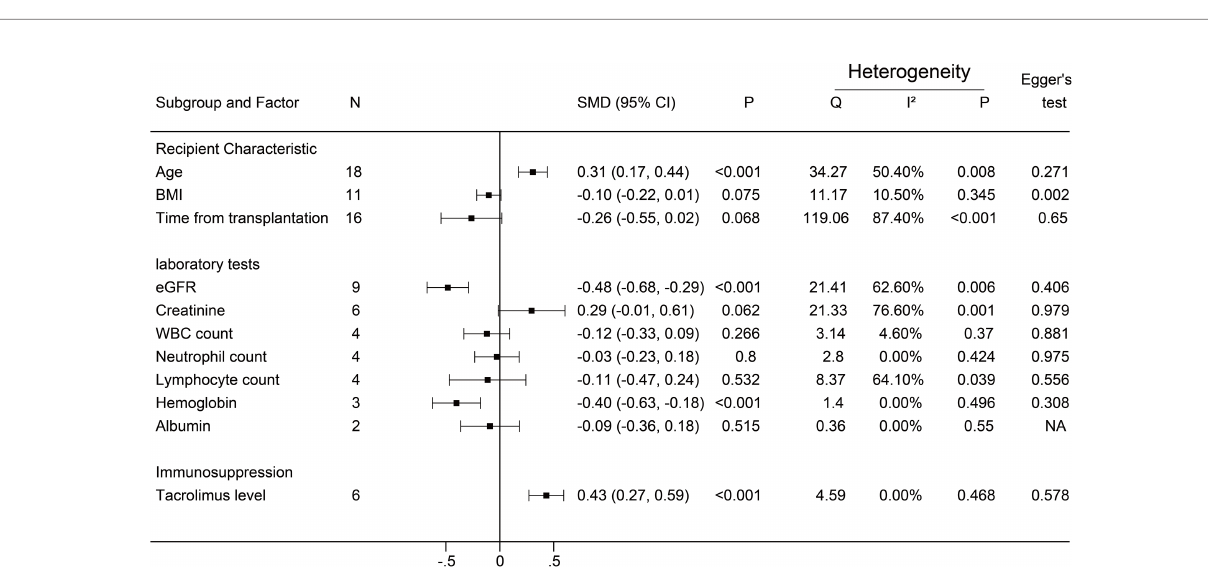
FIGURE 3 | Forest plots of continuous factors.The event was a negative antibody response after vaccination. N, The number of studies; BMI, body mass index; eGFR, estimated glomerular fi ltration rate; WBC, white blood cells. NA indicates missing Egger's test.